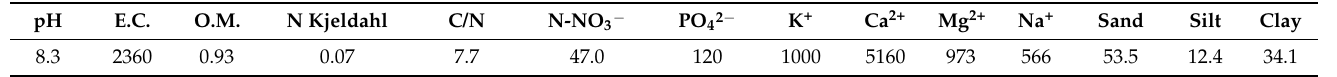
Figure 2. History of the organic plot from cycle 1 to cycle 6. Cycle tomato 6: crop cycle examined in this study. Table 1. Physiochemical properties of the original soil at the beginning of the